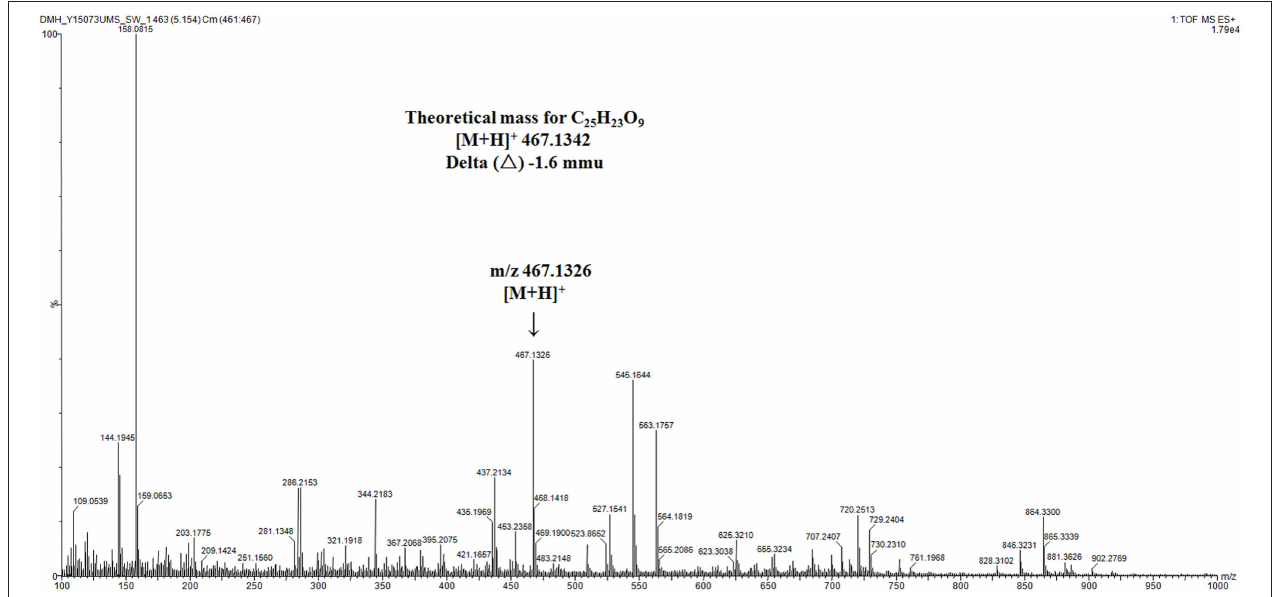
FIGURE 5 | High-resolution mass spectrum of selected ion at t R 5.15min in TIC. mmu, milli-mass units.